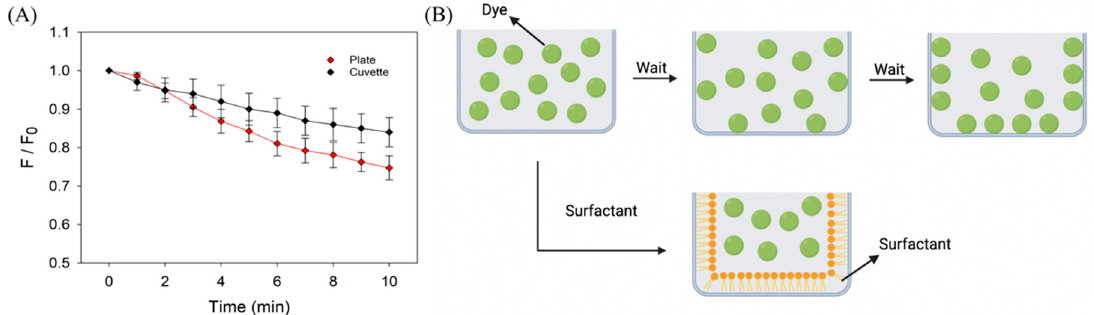
Figure 2. ( A ) Time-dependent fluorescence intensity of the adenosine aptamer and ThT mixture in a polystyrene microplate and a quartz cuvette. ( B ) A scheme showing the adsorption of dyes such as SGI and ThT to the wall of a reaction vessel.